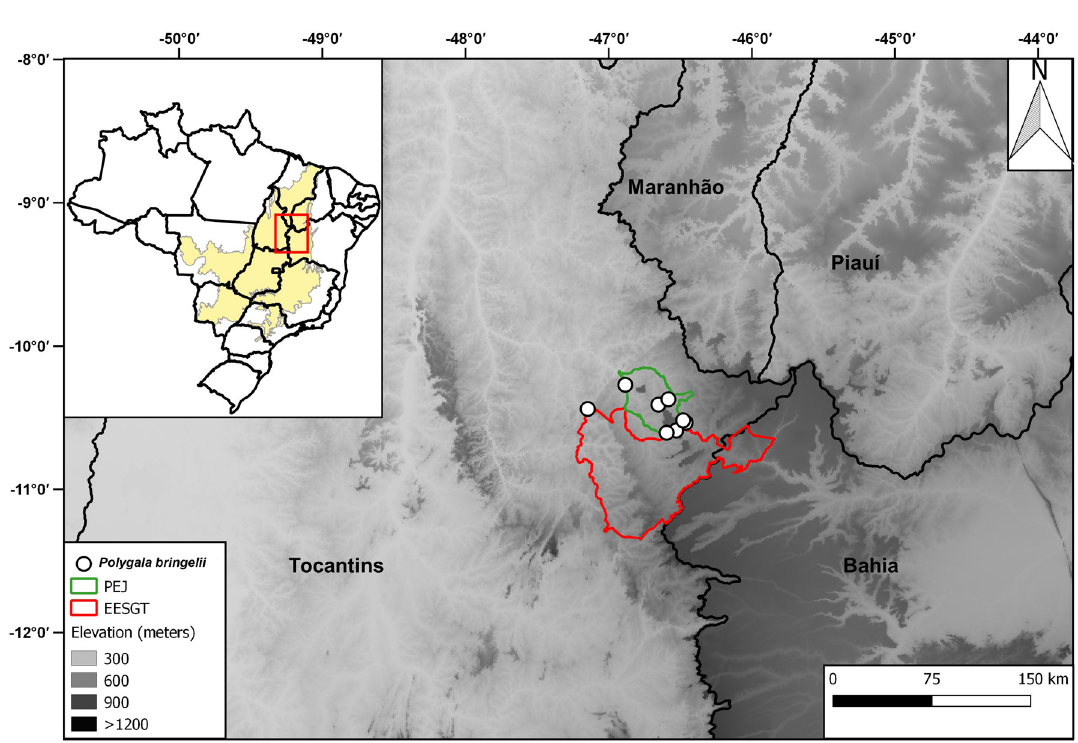
Fig. 3. Geographical distribution of Polygala bringelii J.F.B.Pastore & Antar sp. nov. (circles). PEJ = Parque Estadual do Jalapão, EESGT = Estação Ecológica Serra Geral do Tocantins. The cream-colored portion of the insert map shows the extent of the Cerrado domain in